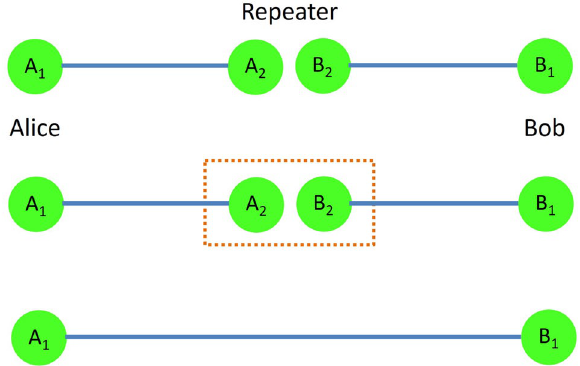
Figure 1. Illustrating the entanglement swapping procedure. Possessing two qubits, A 2 entangled with Alice’s qubit A 1 , and B 2 entangled with Bob’s qubit B 1 , Repeater performs operations and measurements on A 2 and B 2 , leaving Alice’s and Bob’s qubits entangled.